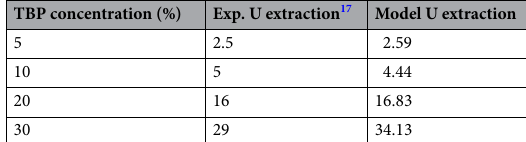
TBP concentration